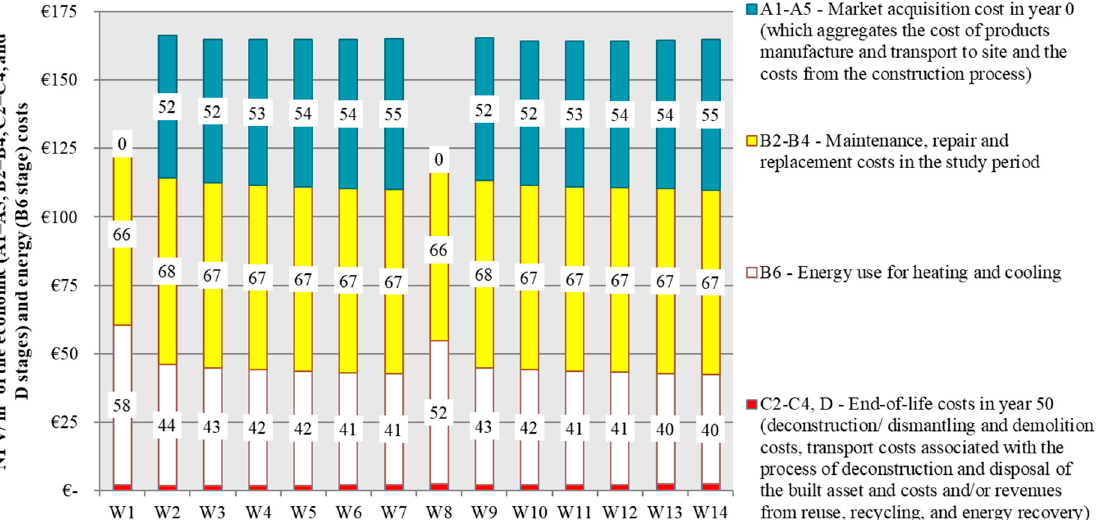
Figure 5. NPV / m 2 of external wall of the economic (A1–A5, B2–B4, C2–C4, and D stages) and energy (B6 stage) costs of ETICS with ICB.